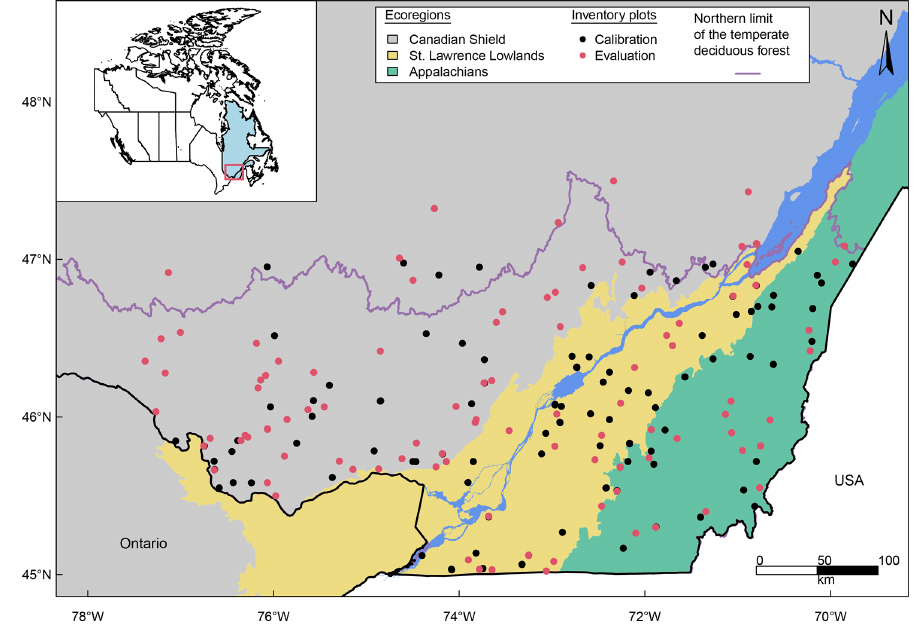
Figure 1. Location of the 200 selected permanent sample plots of the forest inventory of Quebec. The red square in the insert locates the study area within Quebec (in blue) and